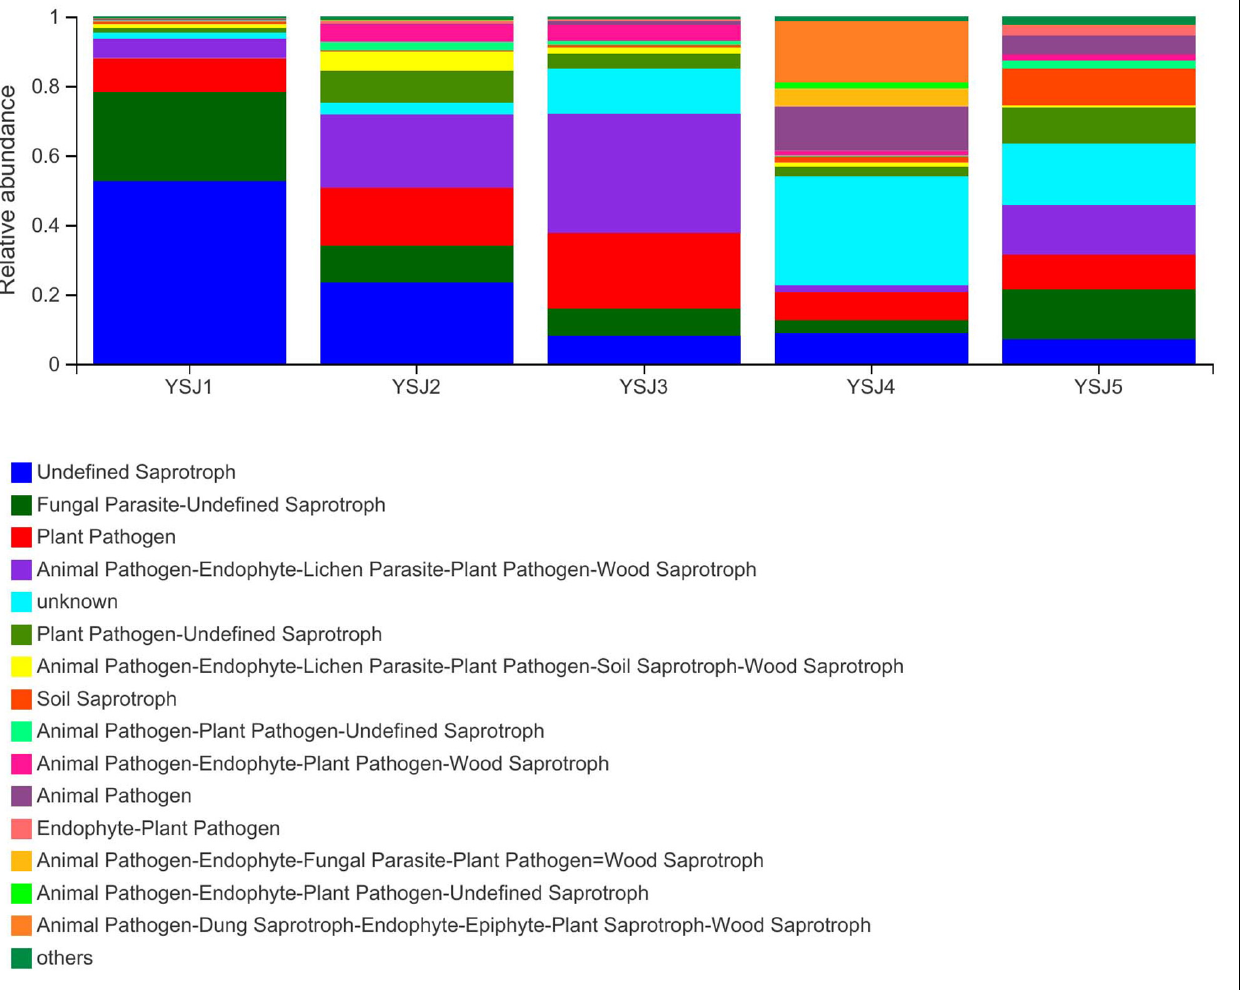
FIGURE 7 | Functional Guild (FUNGuild) analysis of the fungal functional groups. Relative abundance of Guild in different groups or samples is depicted on the x-axis and groups or samples are presented on the y-axis . According to variation in the functional group, FUNGuild can calculate the abundance of each fungal species and its functional classification in each